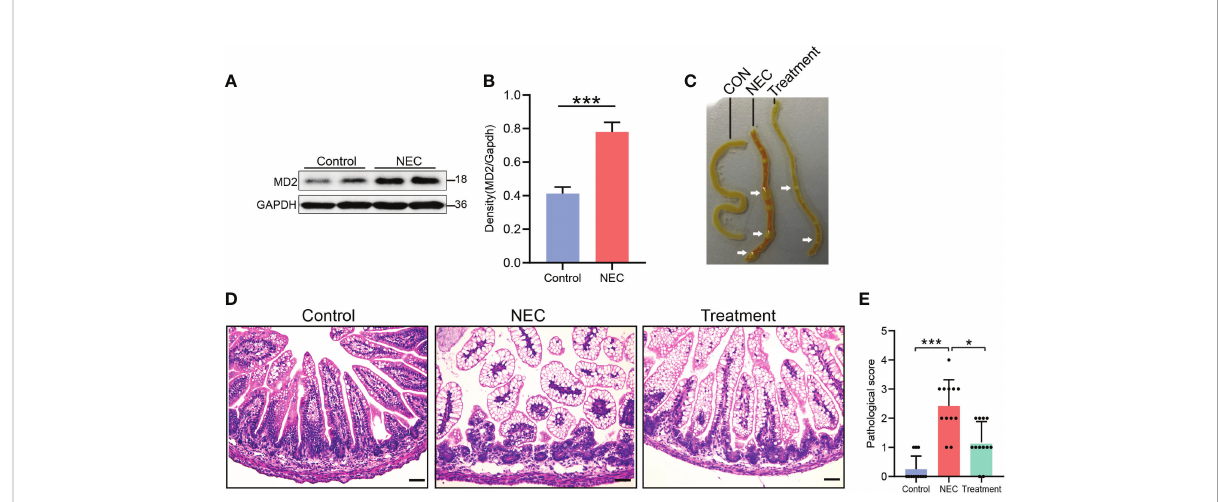
FIGURE 2 Evaluation of pathological condition, histological score and MD2 protein expression in NEC rats. (A, B) The expression of MD2 in the intestinal tissue of NEC neonatal rats was detected by western blot analysis (n=4). The p value for each group comparison using a two-tailed Student ’ s t test. ***p < 0.001. (C) Representative images showing the gross intestinal morphology. (D, E) Histological H&E staining of the transverse section of ileal tissue and histological NEC score in each group. Scores of 2 or more were regarded as NEC positive. Scale bar, 50 m m. Data are presented as the mean ± SD (n=12) and analyzed by the Kruskal – Wallis test. *p <0.05, ***p